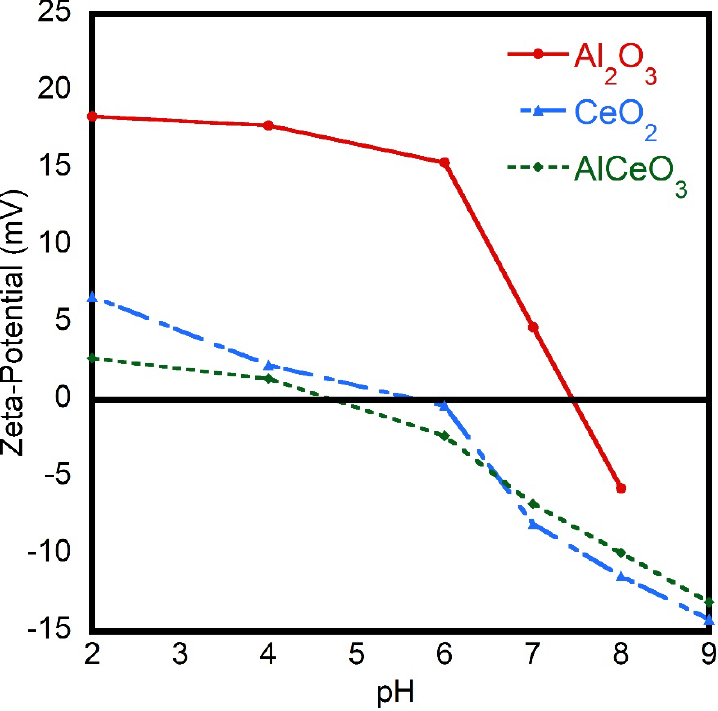
Figure 6. Zeta-potential vs. pH values of Al 2 O 3 , CeO 2 , and AlCeO 3 nanopowders.